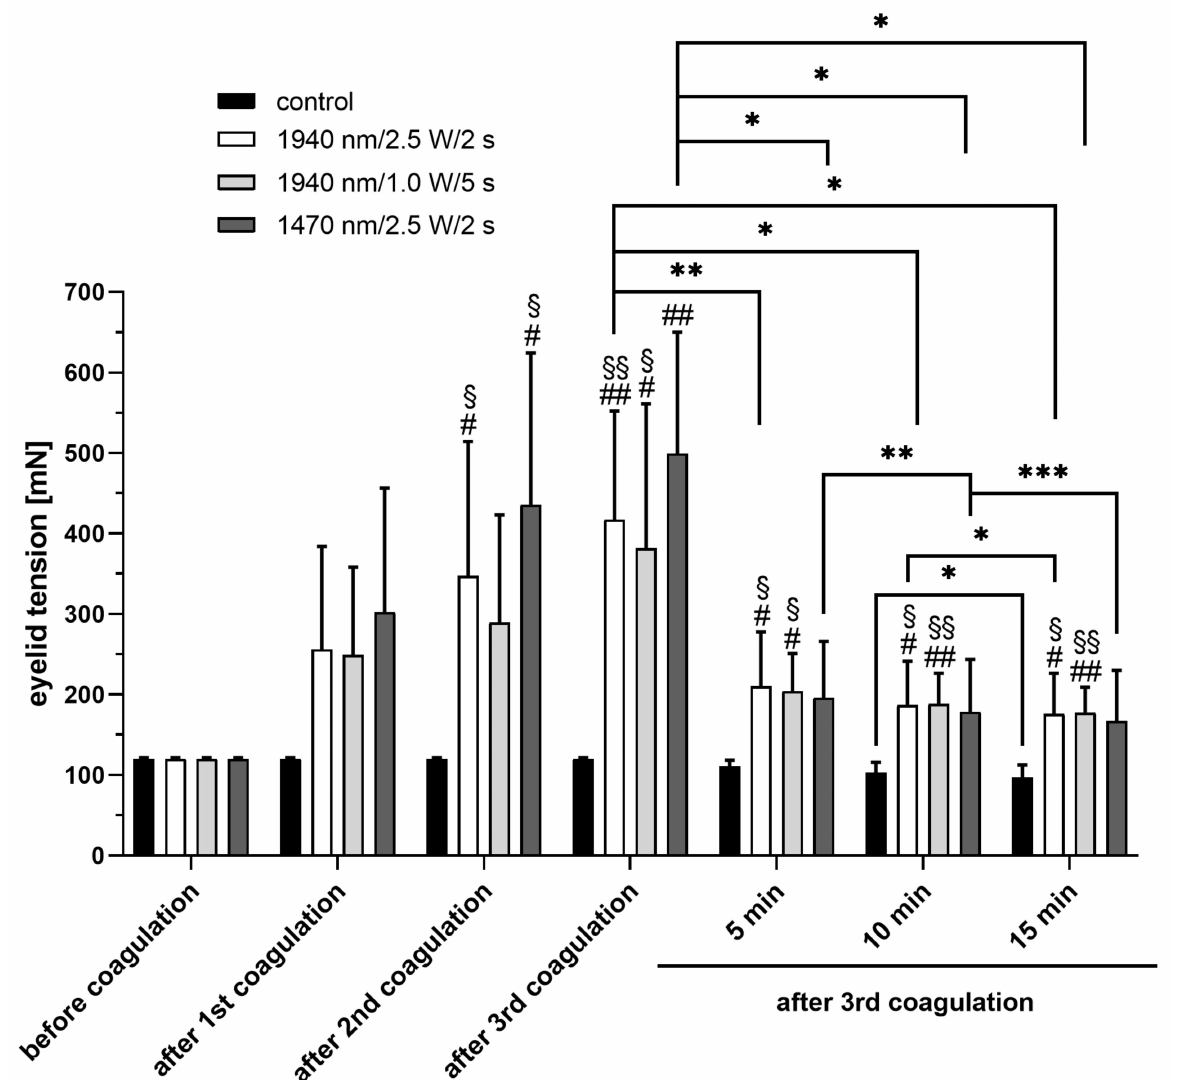
Figure 2. Changes in eyelid tension before and after irradiation using three different laser settings. # p < 0.05, ## p < 0.01 compared to before coagulation. § p < 0.05, §§ p < 0.01 compared with control group. * p < 0.05, ** p < 0.01, *** p <